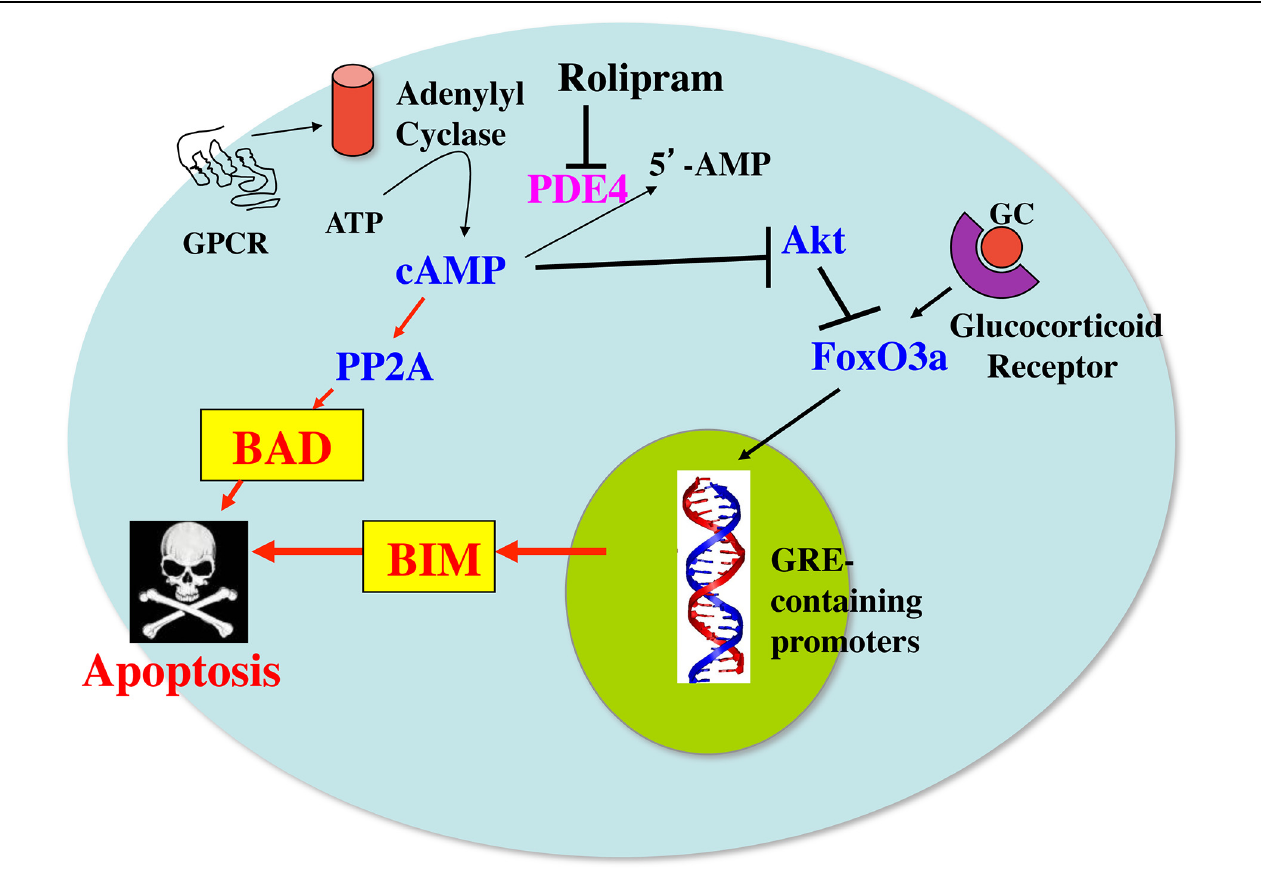
FIGURE 7 | Model for the synergy between cAMP and glucocorticoid signaling pathways on induction of apoptosis in leukemic and multiple myeloma cells. GC, glucocorticoids; GPCR, G protein coupled receptor; PP2A, protein phosphatase 2A; PDE4, phosphodiesterase4; GRE, glucocorticoid-responsive